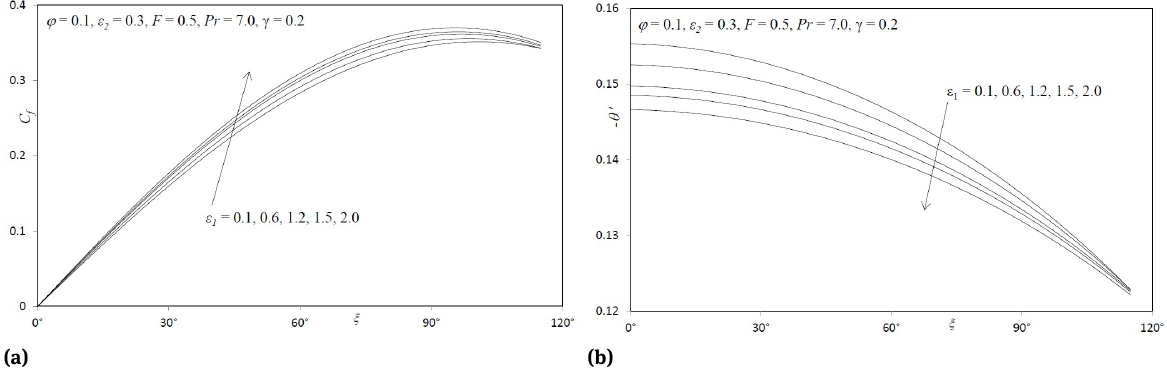
Fig. 10: (a) Effect of ϵ 1 on Skin Friction; (b) Effect of ϵ 1 on Nusselt number